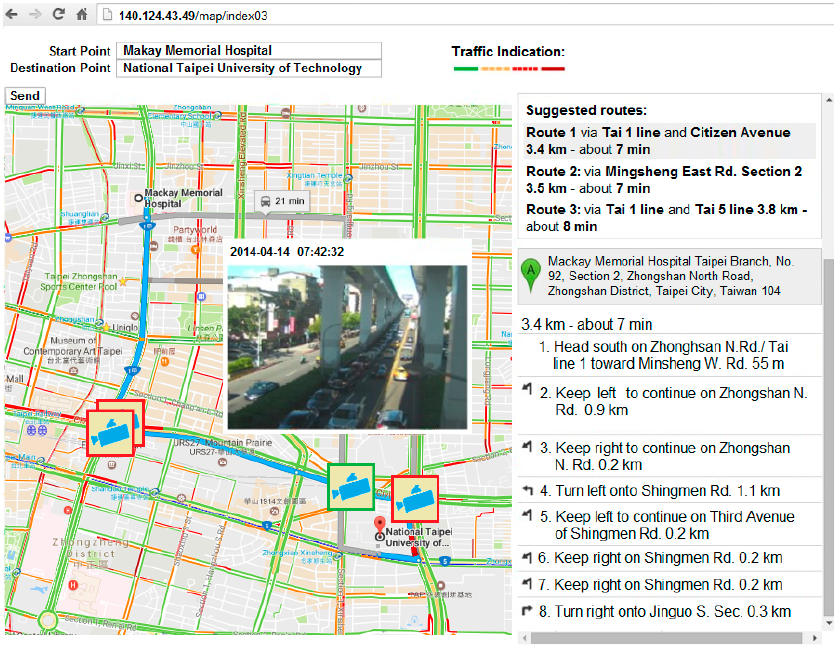
Figure 6. The traffic guiding system. The first route is chosen among the three suggested routes by Google Maps along Civic Boulevard road is congested.